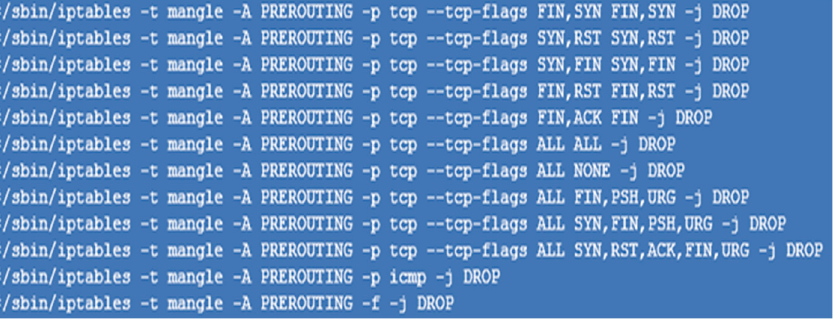
Figure 5. Iptables in internet environment.